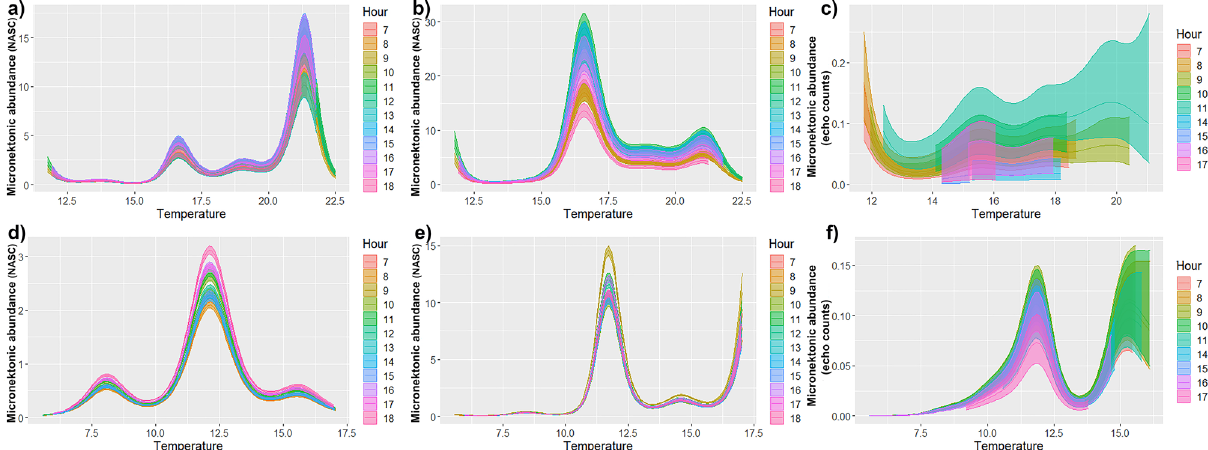
Figure 5. Fit of the of the temperature per hour for ( a ) average depth and oxygen in micronekton from surface at 18 kHz, ( b ) for average depth and oxygen in micronekton from surface at 38 kHz ( c ) for average depth in micronekton from surface at high frequency, ( d ) for average oxygen in micronekton from deep layers at 18 kHz, ( e ) for average oxygen in micronekton from deep layers at 38 kHz and ( f ) for average salinity and oxygen in micronekton from deep layers at high frequency. The upper and lower lines for each time of the day represent the 95% confidence intervals around the fitted values (middle line). This figure was created using R version 4.1.3 (2022-03-10) (https:// www.r- proje ct.